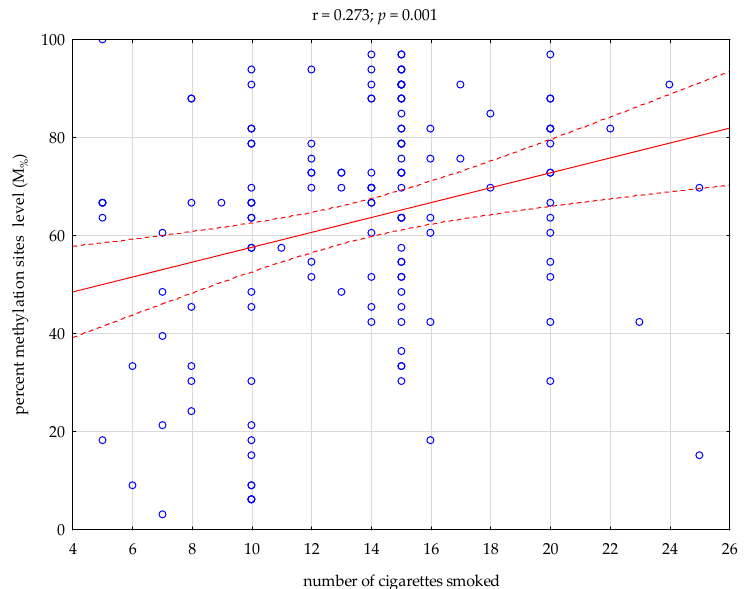
Figure 2. Correlation between percent methylation sites (M % ) of 33 CpG DAT1 sites and the number of cigarettes smoked in a group of nicotine-dependent subjects (ND).